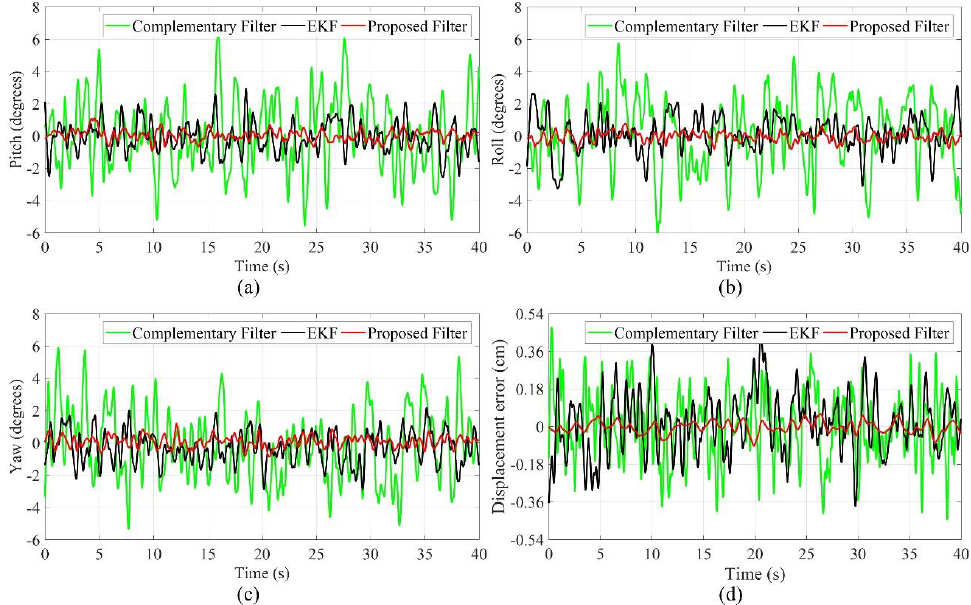
Figure 13. Drilling test at high speed ( a ) pitch angle; ( b ) roll angle; ( c ) yaw angle; ( d ) displacement